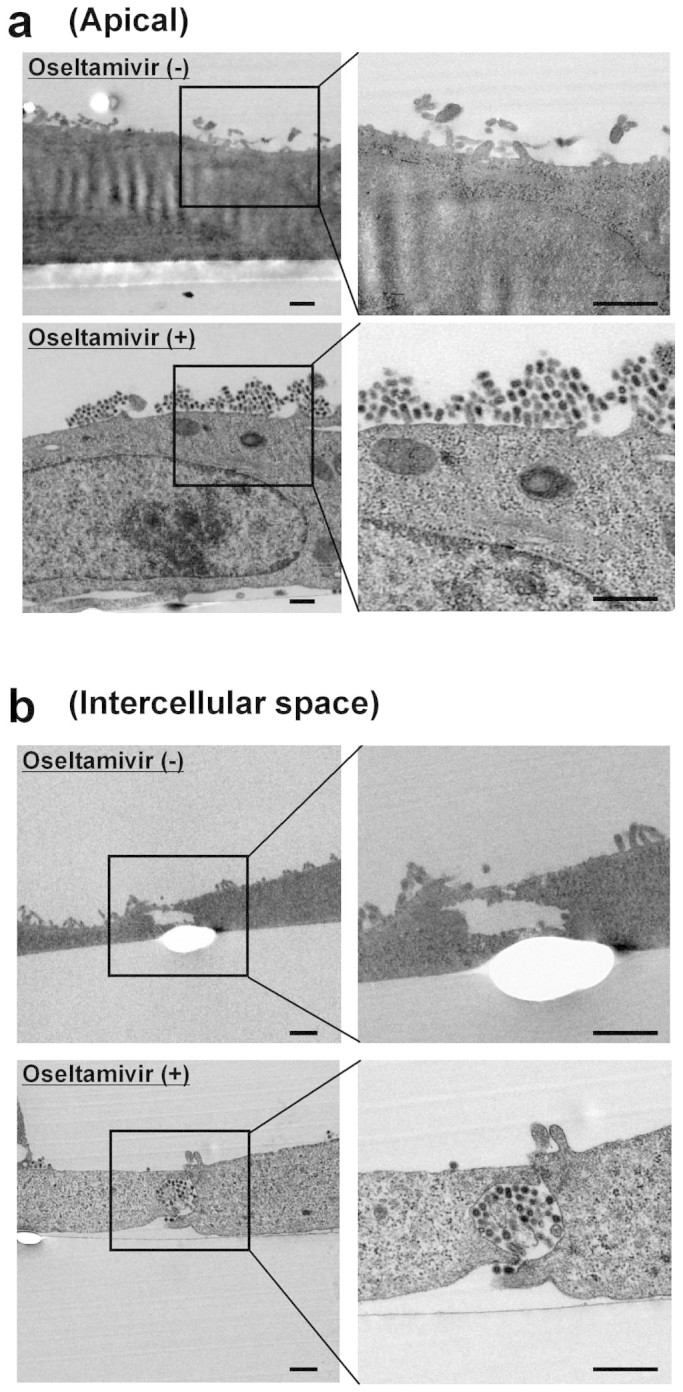
Prominent localization of influenza virus in intercellular space in the presence of oseltamivir.MDCK cells were infected with influenza virus WSN/33 at MOI of 10 and cultured in the absence or presence of 50 μg/ml of oseltamivir phosphate. After incubation at 37°C for 16 hours, transmission electron microscopic analyses were performed. (a) Virions accumulated on apical plasma membrane. (b) Virions accumulated in intercellular space. Enlarged views are shown in borders. Scale bar, 500 nm.